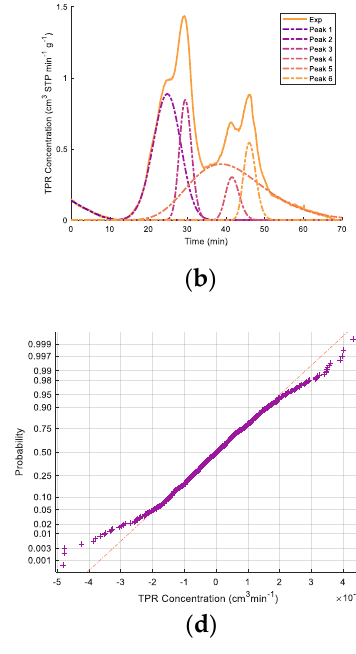
CaO- γ-Al 2 O 3 catalyst sample: ( a ) adjustment curve with R 2 = 0.9996, ( b ) composition curves, ( c ) regression